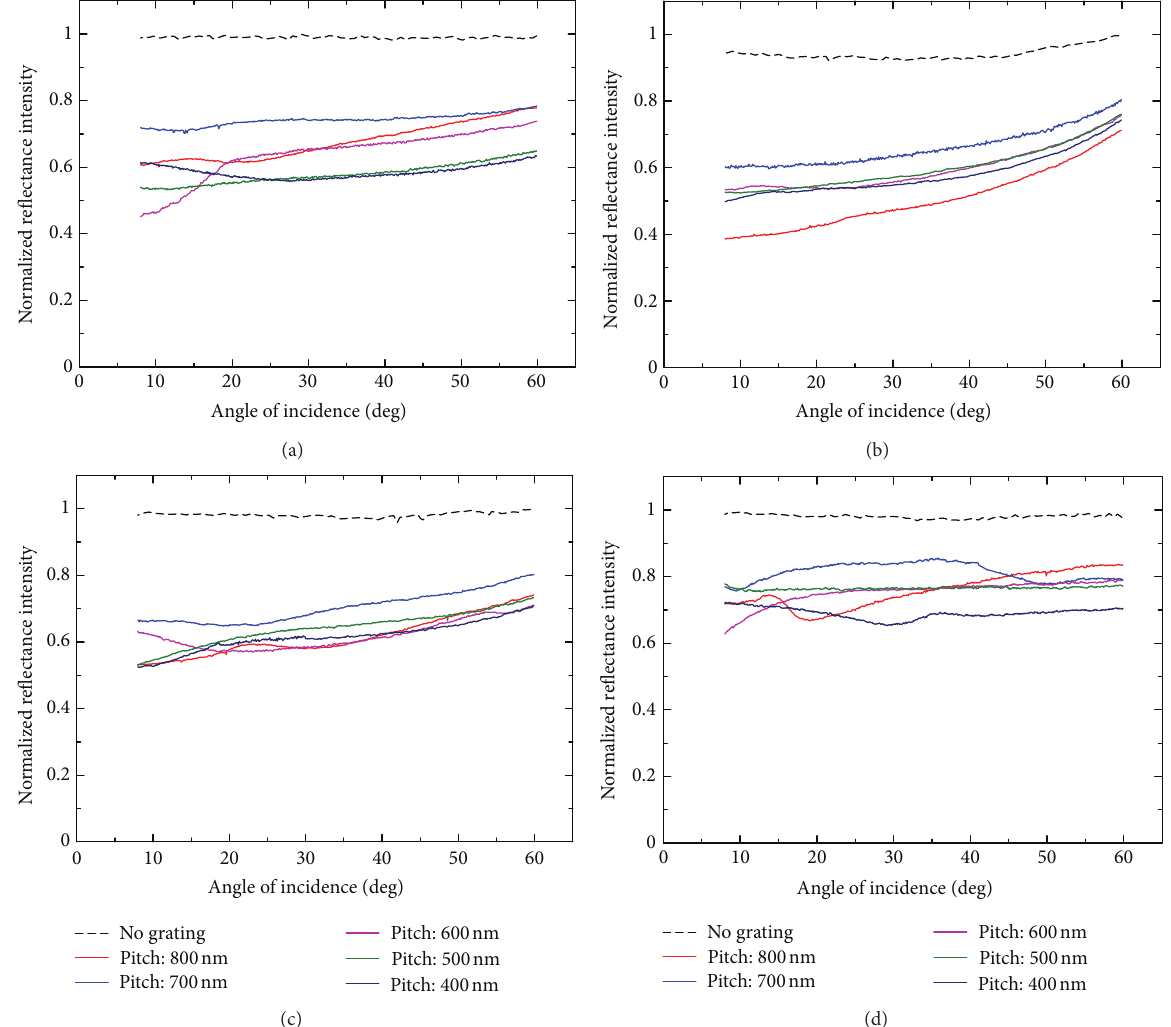
Figure 3: Normalized reflectance intensity as a function of incident angles for grating pitches = 400, 500, 600, 700, 800nm and a planar reference sample (Au film without grating). The samples illuminated by a white light source (a) and three visible wavelengths 488nm